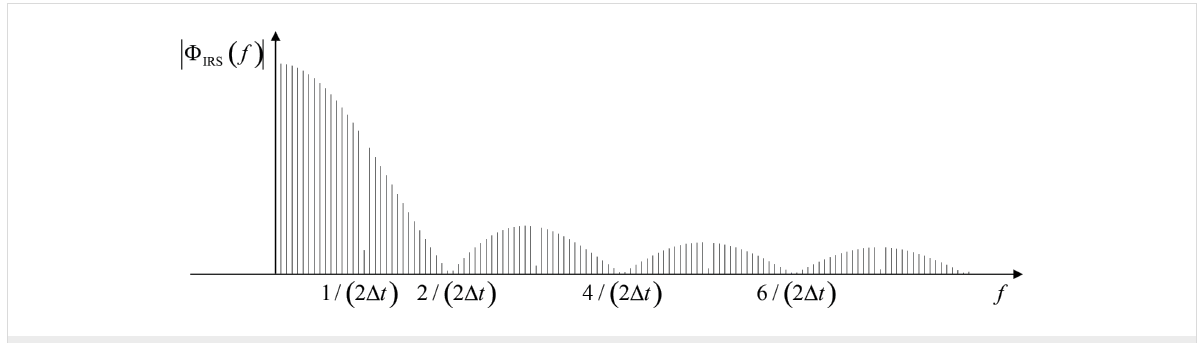
Figure 3: Shape of the power spectrum of IRS from 5-bit length shift register.